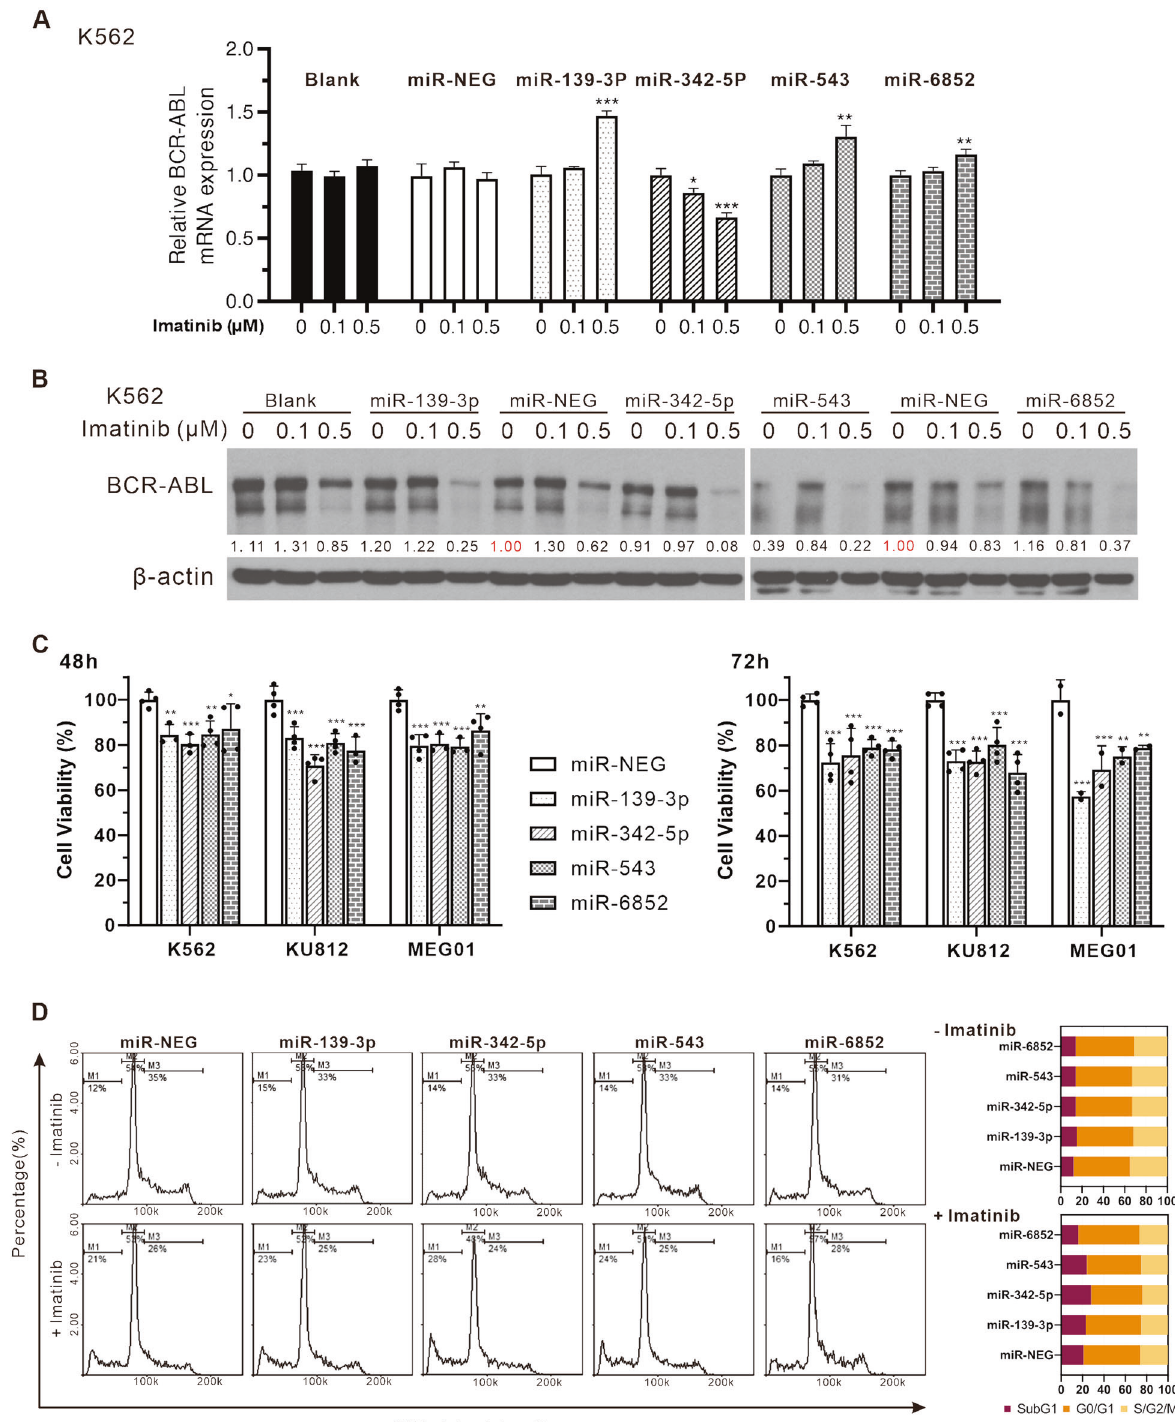
Fig. 2 Assessment of the effect of four miRNAs on cell viability and BCR-ABL expression in the presence or absence of imatinib treatment in various CML cell lines. Effect of imatinib on BCR-ABL expression by qPCR ( A ) and western blot ( B ) in the expression of four miRNAs. C The effects of adding four miRNAs at 48 and 72 hours on CML proliferation were presented by XTT assay. A one-way ANOVA approach was used to assess the signi fi cance of the effects of each miRNA compared with miR-NEG. Each data represents mean ± SD from independent experiments performed in triplicate. * P < 0.05; ** P < 0.01; *** P < 0.001. D The effect of miR-NEG and four miRNAs on cell cycle distribution of K562 was evaluated by NC-3000 TM NucleoCounter ® (ChemoMetec, Denmark) with or without imatinib (0.5 μ M, 48 h) treatment, and the results quanti fi ed for different phases are shown on the